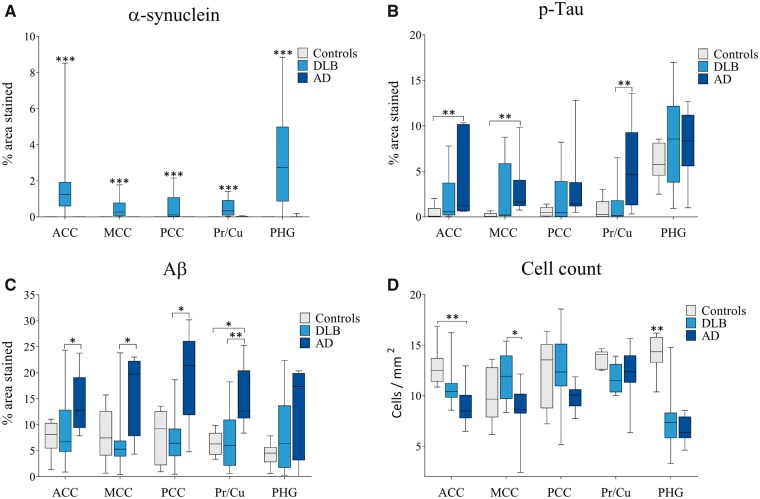
Pathological and cell number changes in cingulate subregions, precuneus/cuneus and parahippocampal gyrus in older normal, dementia with Lewy bodies (DLB), and Alzheimer disease (AD) donors. Postmortem brain tissue from DLB, AD, and control donors was sampled in specific brain regions associated with the cingulate island sign and 10-μm-thick tissue sections immunohistochemically stained to demonstrate neurodegenerative pathology, or stained using standard cresyl fast violet stain to demonstrate cellular morphology. Pathological burden (% area stained) was determined using computer-aided image analysis of (A) α-synuclein; (B) phosphorylated Tau (p-Tau); (C) amyloid-β (Aβ); and a stereological approach used to determine (D) neuronal number (mm2) in anterior cingulate cortex (ACC), midcingulate cortex (MCC), posterior cingulate cortex (PCC), precuneus/cuneus (Pr/Cu), and parahippocampal gyrus (PHG). Bars represent mean and SD (controls n = 6; DLB n = 12; and AD n = 9). α-Synuclein was significantly higher in DLB in all regions studied compared with both AD and control groups (A). Phosphorylated tau burden was significantly higher in AD compared with controls in ACC and MCC (B). Aβ burden was also higher in AD compared with DLB in all cingulate regions but did not differ from controls (C), whereas cell count in AD ACC was reduced compared with control and in MCC compared with DLB (significance levels set at *p < 0.05, **p < 0.01, and ***p < 0.001). Box plots represent the median (midline) and quartile ranges, with error bars representing the minimum and maximum values.